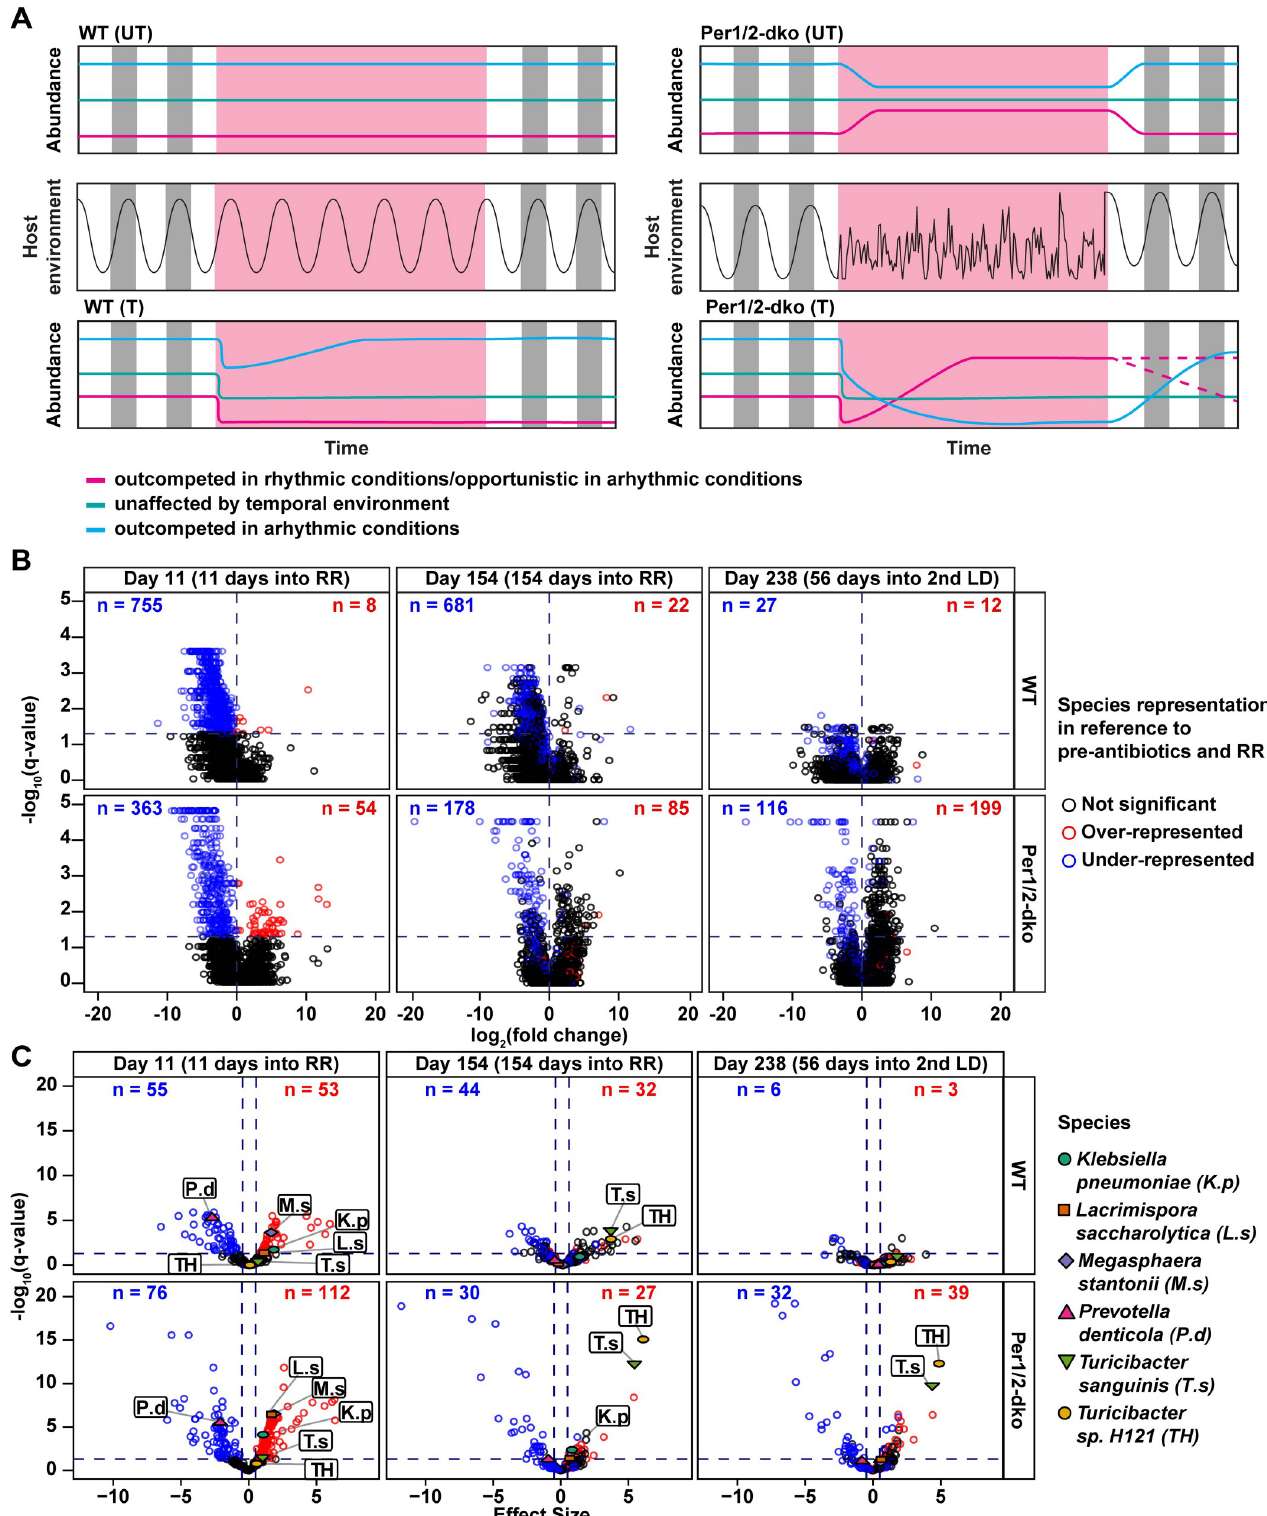
Fig 4. Predictions based on temporal control of the microbiome and volcano plots for changes in species composition during recovery from antibiotic perturbation. ( A ) Predictions based on temporal control of the microbiome based on transitions between LD (vertical gray/white bars) and RR